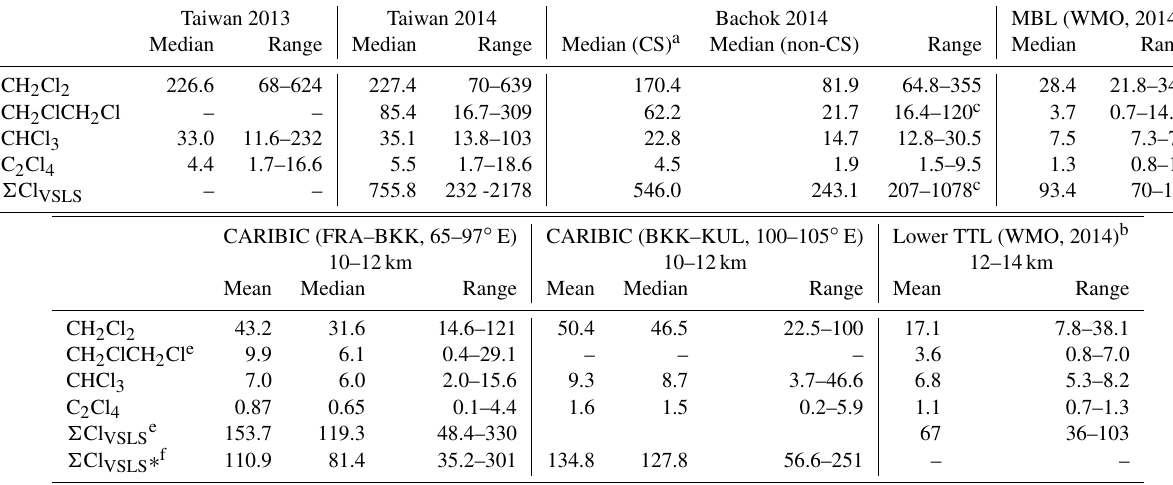
a CS and non-CS refer to the cold surge (polluted) and non-cold surge periods at Bachok. b The WMO data are a compilation of all reported global measurements up to, and including, the year 2012. The range represents the smallest mean minus 1 standard deviation and the largest mean plus 1 standard deviation of all considered datasets. Data from the TTL were derived from various aircraft and balloon campaigns. c CH 2 ClCH 2 Cl was only analysed for in 16 of the 28 samples collected at Bachok. d Note that the CH 2 ClCH 2 Cl MBL data actually date back to the early 2000s. No recent data were reported. e CH 2 ClCH 2 Cl was only analysed for